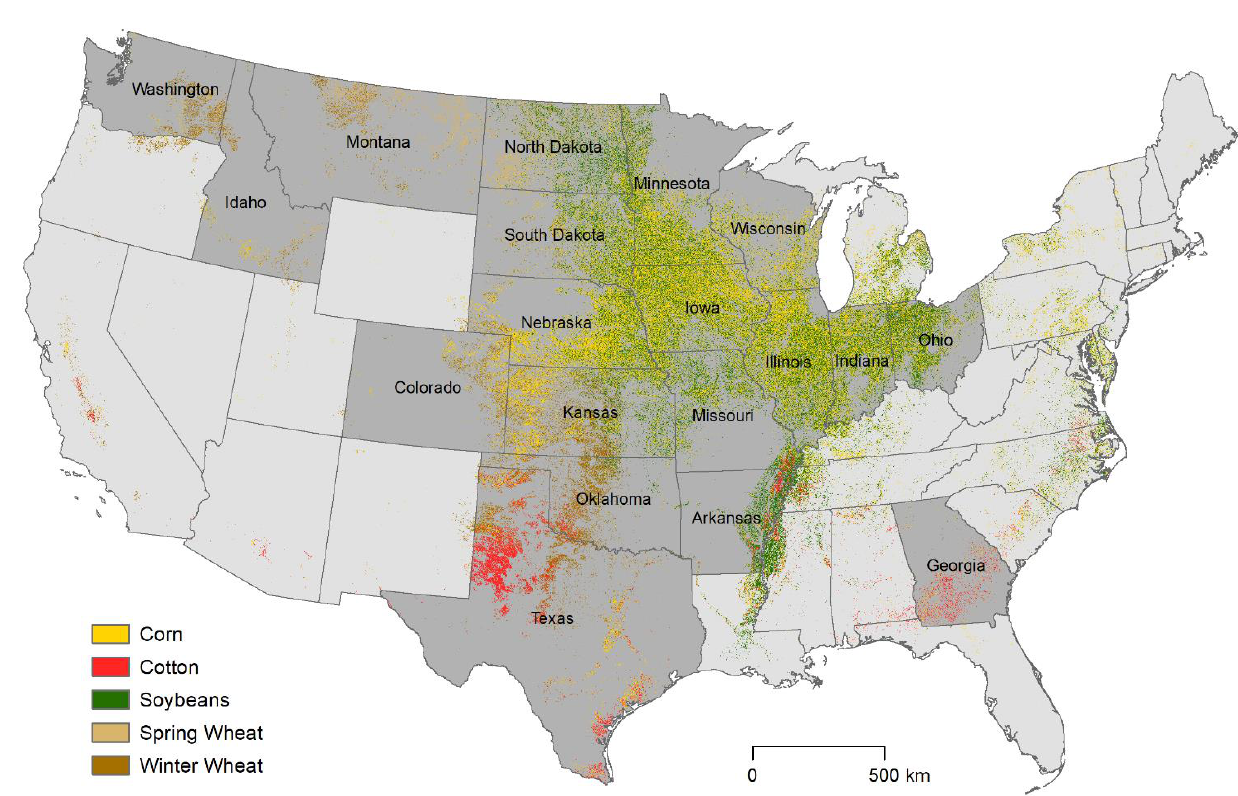
Figure 1. Study area. USA states in dark grey represent those that were also focused on for state-level yield assessment in addition to national-level. Crops shown are from the 2020 USDA NASS Cropland Data Layer.